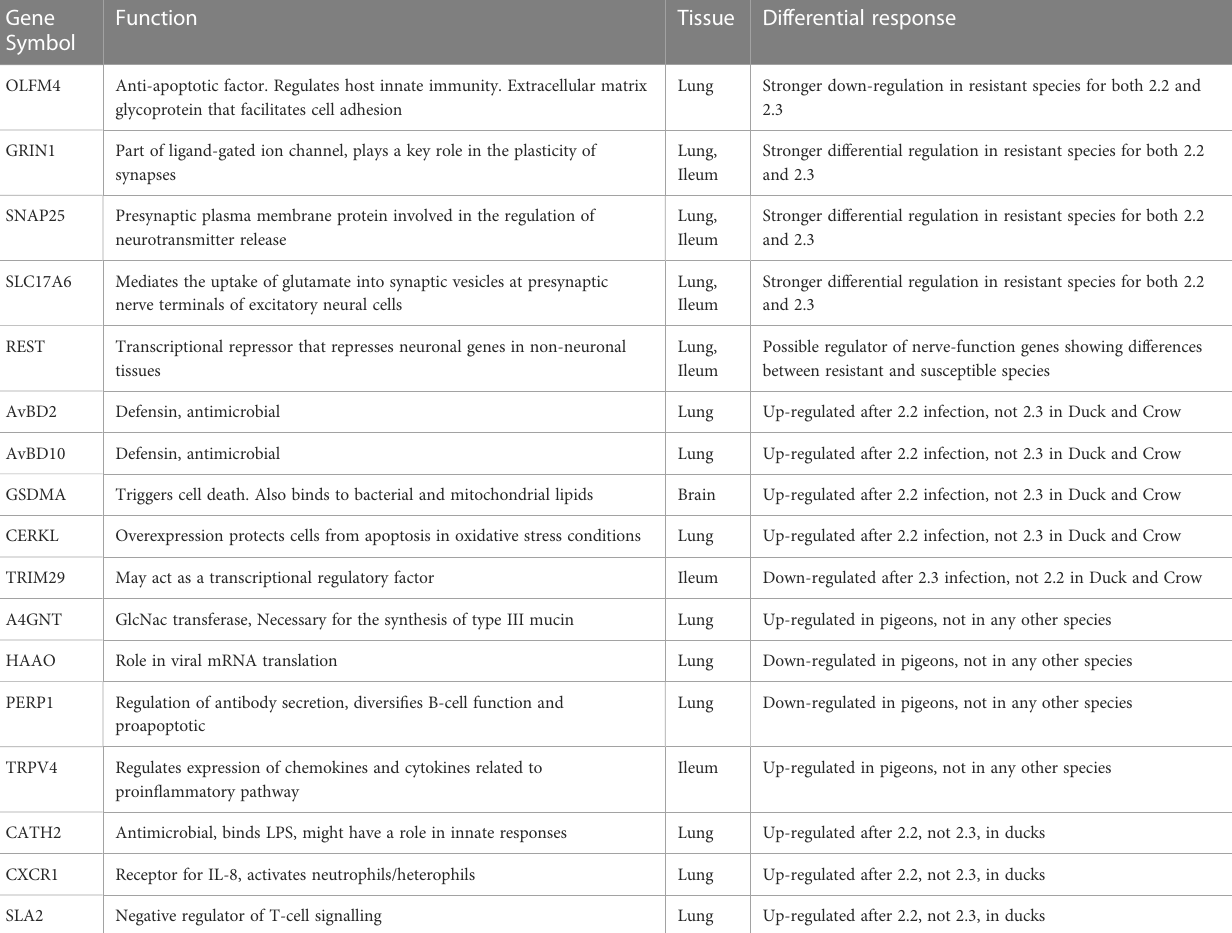
TABLE 4 Candidate genes with possible roles in